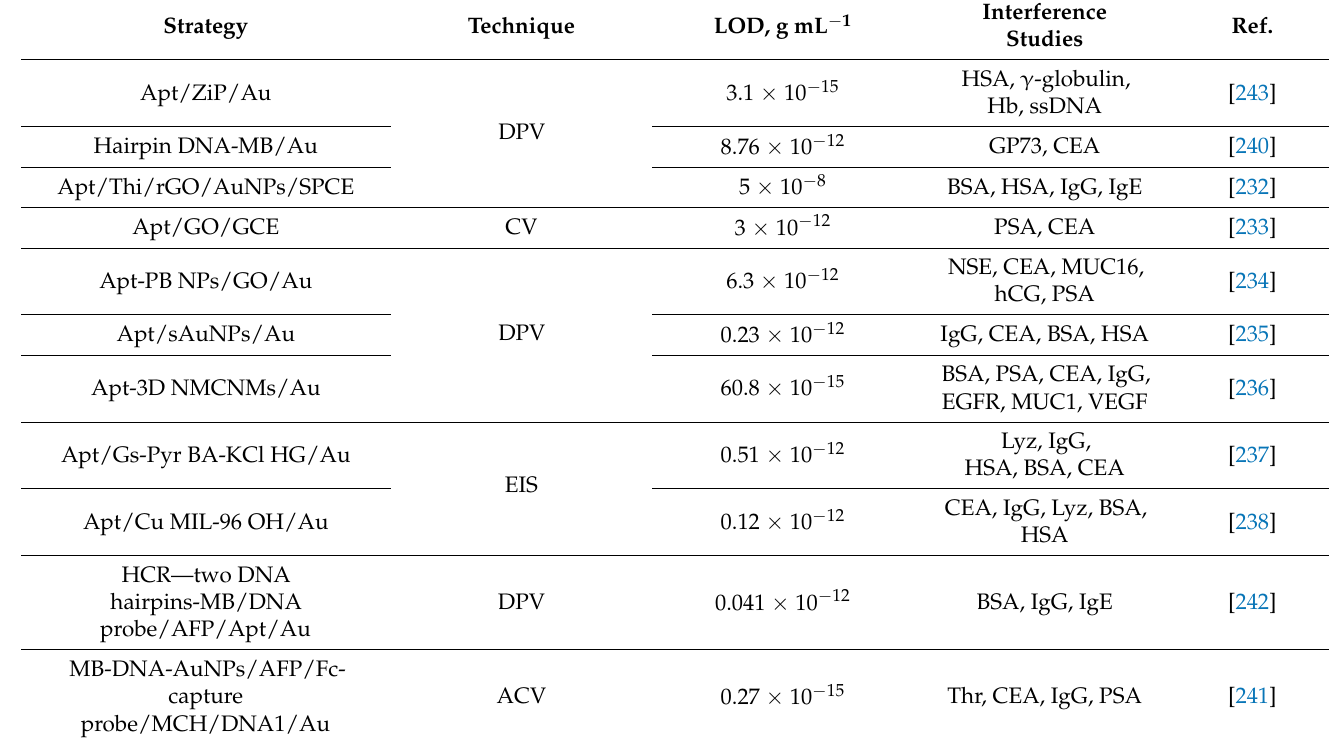
Table 5. The analytical performance of selected electrochemical aptasensors for AFP. Strategy Technique LOD, g mL − 1